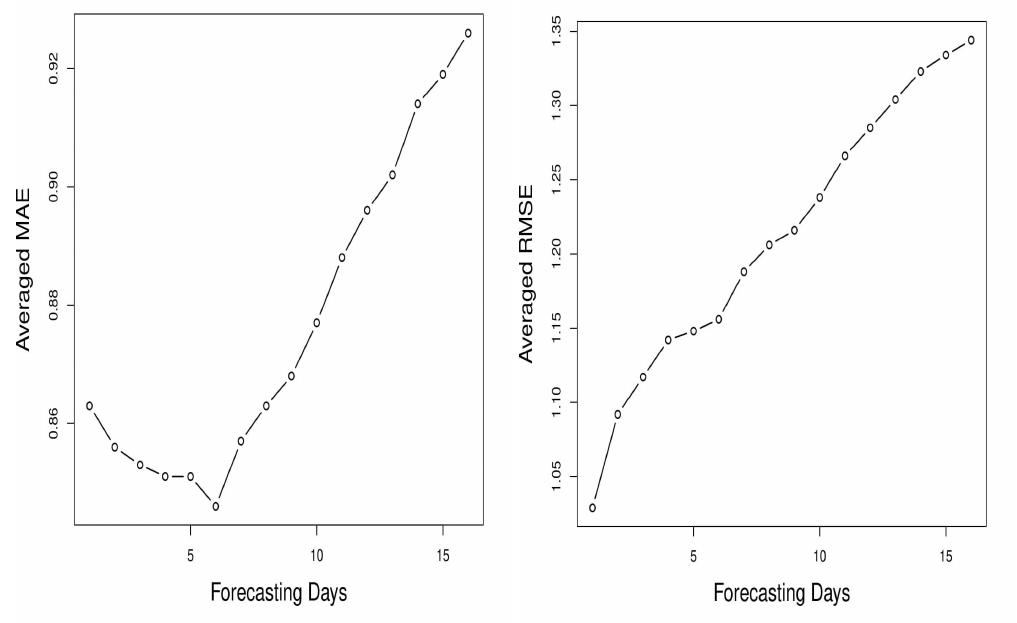
Figure 11. Sensitivity of DI prediction error to forecast window size (1–16 days), measured using average MAE and RMSE, under supervised learning and GEFS climate